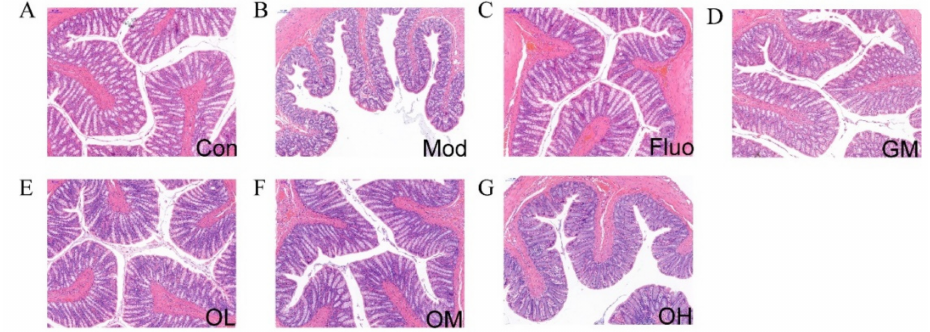
Figure 4. The result of colon HE staining. ( A ). Con, control group; ( B ). Mod, CUMS group; ( C ). Fluo, CUMS rats treated with fluoxetine; ( D ). GM, CUMS rats treated with green tea dhool at a middle dose; ( E ). OL, CUMS rats treated with jasmine tea at a low dose; ( F ). OM, CUMS rats treated with jasmine tea at a middle dose; ( G ). OH, CUMS rats treated with jasmine tea at a high